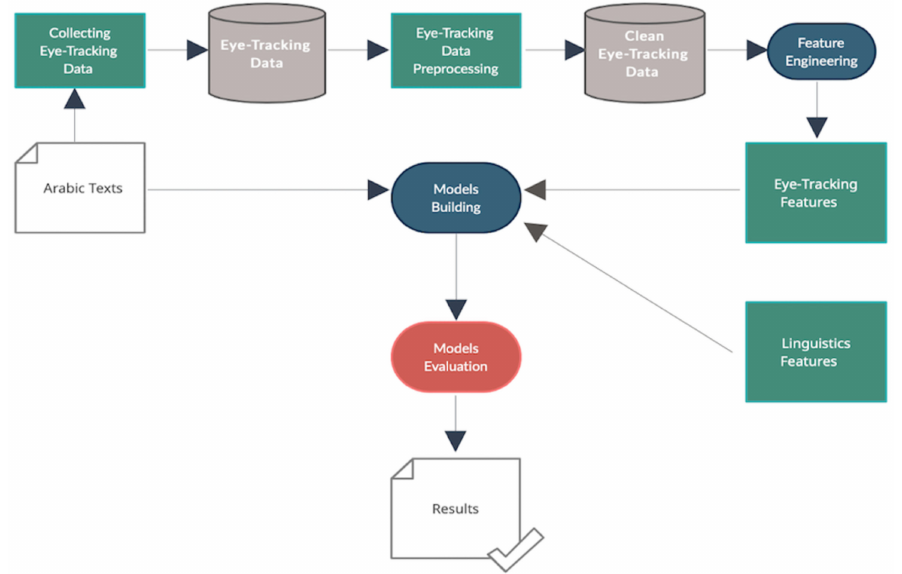
Figure 1. Research methodology